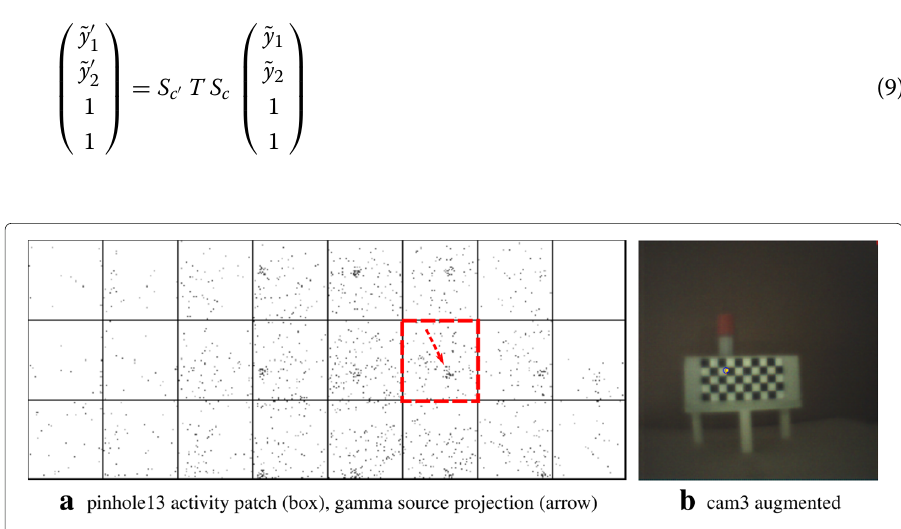
Fig. 13 Pair 4, known source distance 150 mm ( x 3 ), acquisition time 16 s. a Activity image. b The exit pupil and the activity blob match almost